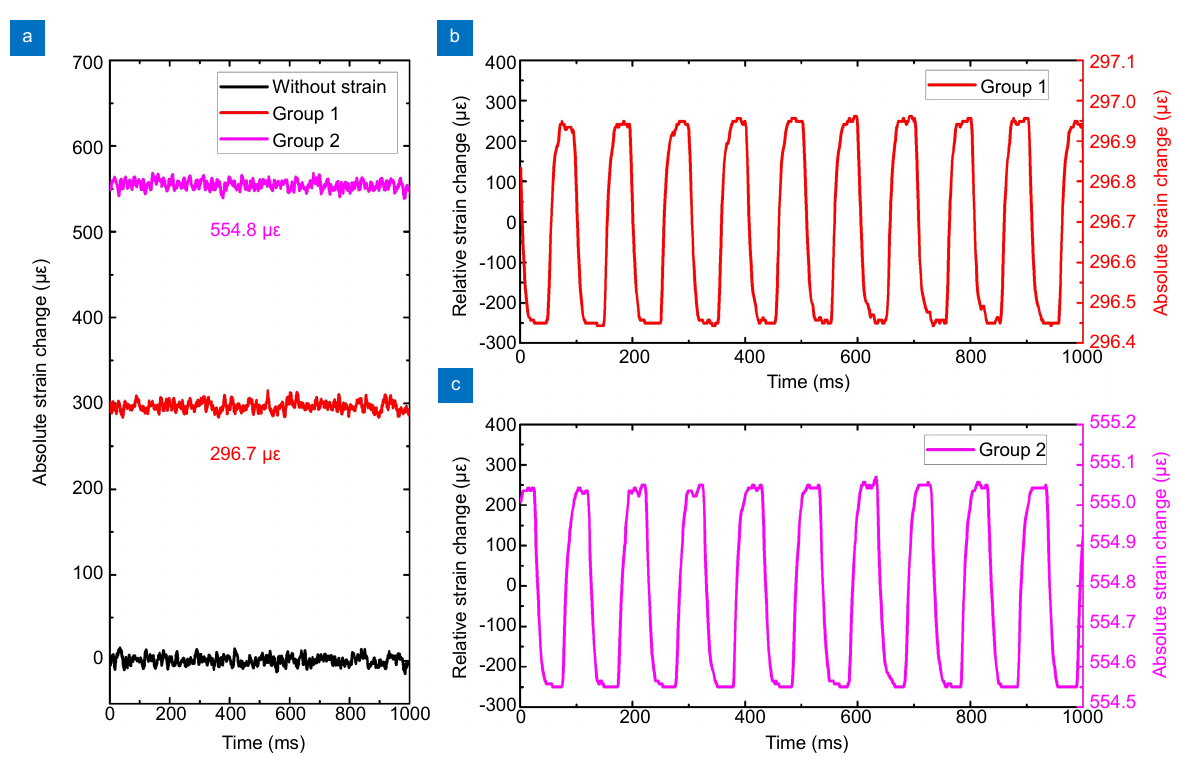
Fig. 7 | Two groups of vibration measurements by integrating the Rayleigh and Brillouin strain information. ( a ) The dynamic strain meas- urement results of two groups using the BOTDA. ( b , c ) The dynamic strain measurement results of the group 1 (b) and group 2 (c) employing the φ -OTDR,